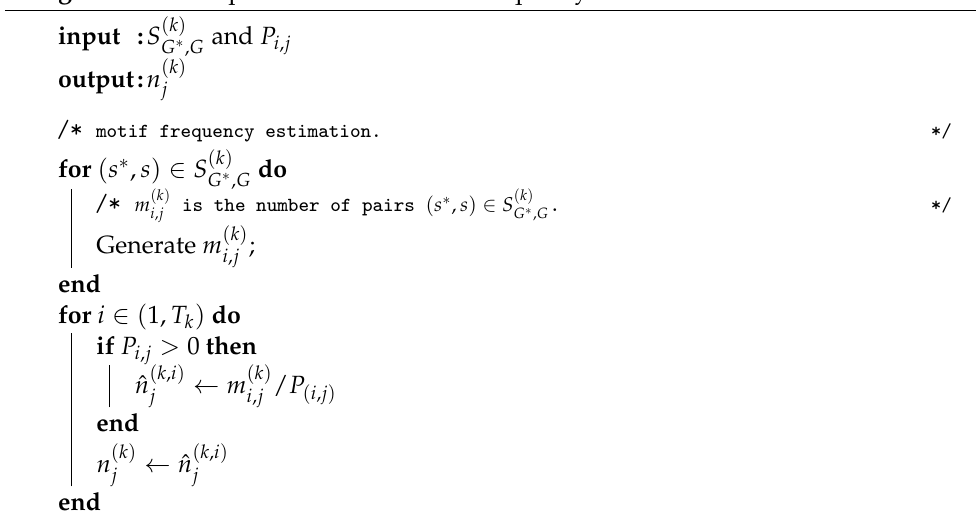
Algorithm 2: The pseudocode for Motif Frequency